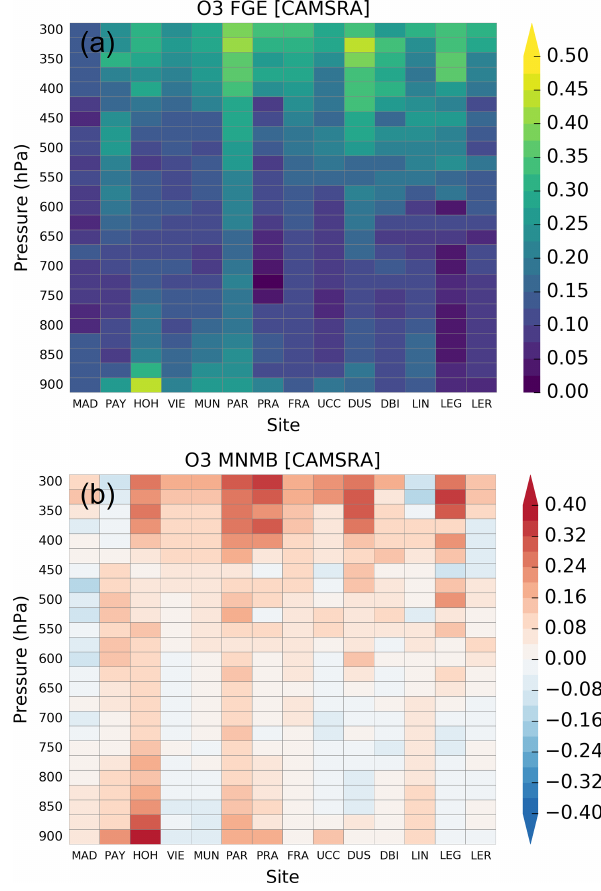
Figure 6. Vertical profiles of CAMSRA ozone (a) FGE and (b) MNMB for the examined WOUDC ozonesonde stations and IAGOS airports over the period 2003–2018. The observational sites are ordered with increasing